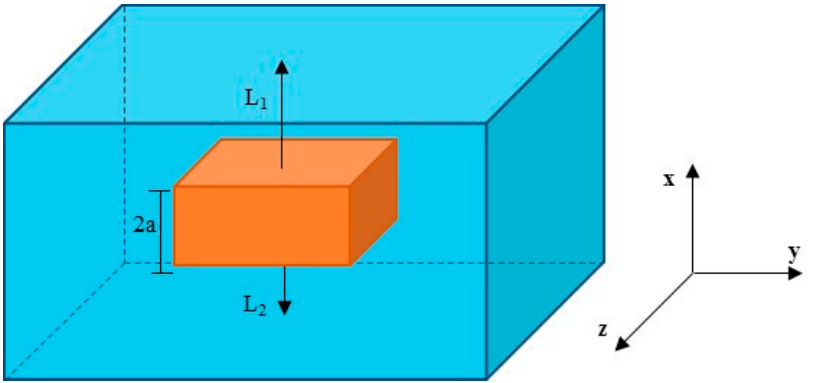
Figure 1. Geometric representation of the studied physical problem.